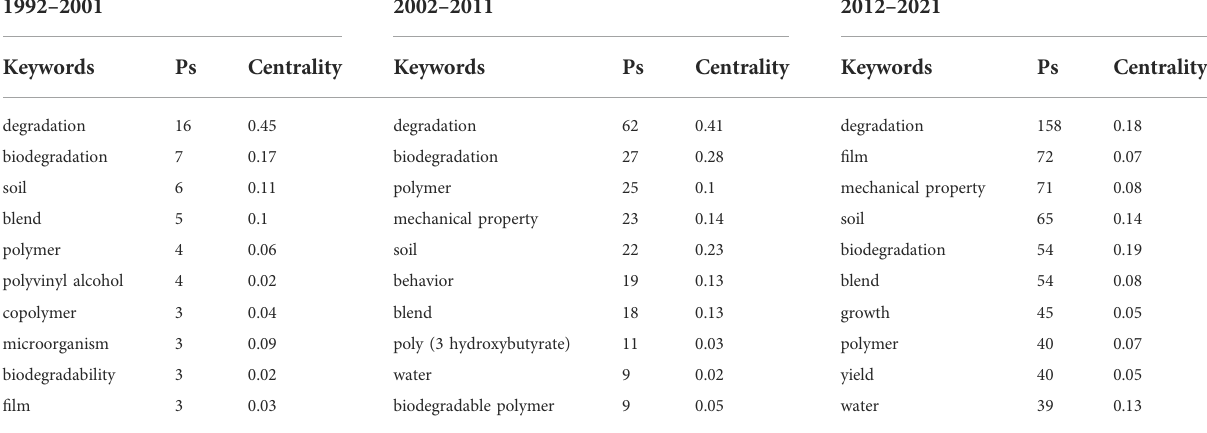
TABLE 6 Related keywords of biodegradable fi lms for soil in different periods from 1992 to